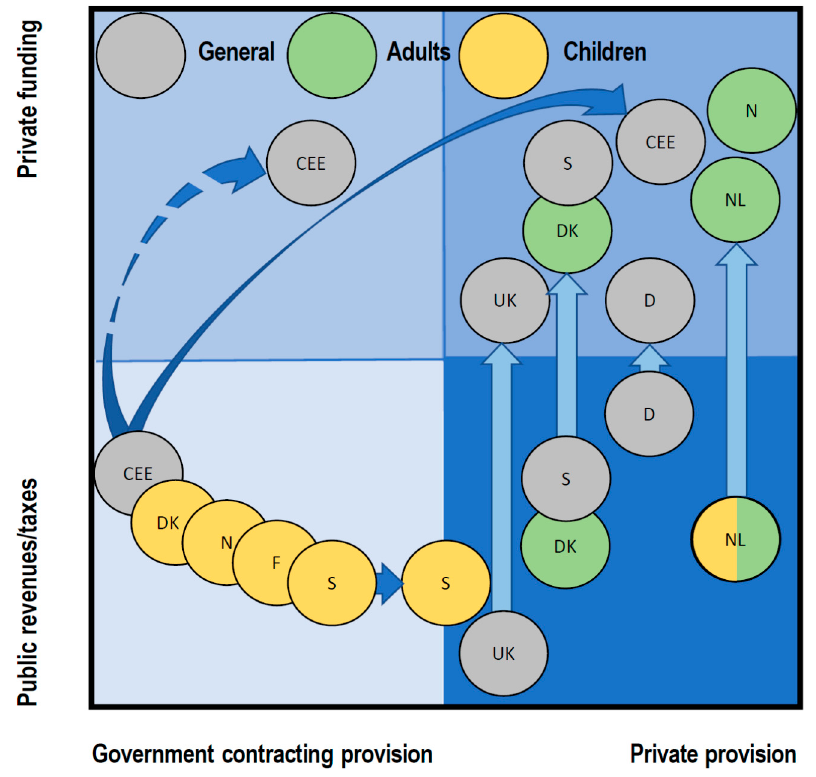
Figure 30. A scheme of exemplary changes in the method of financing health care in some European countries generally for all habitants, whether adults or children.